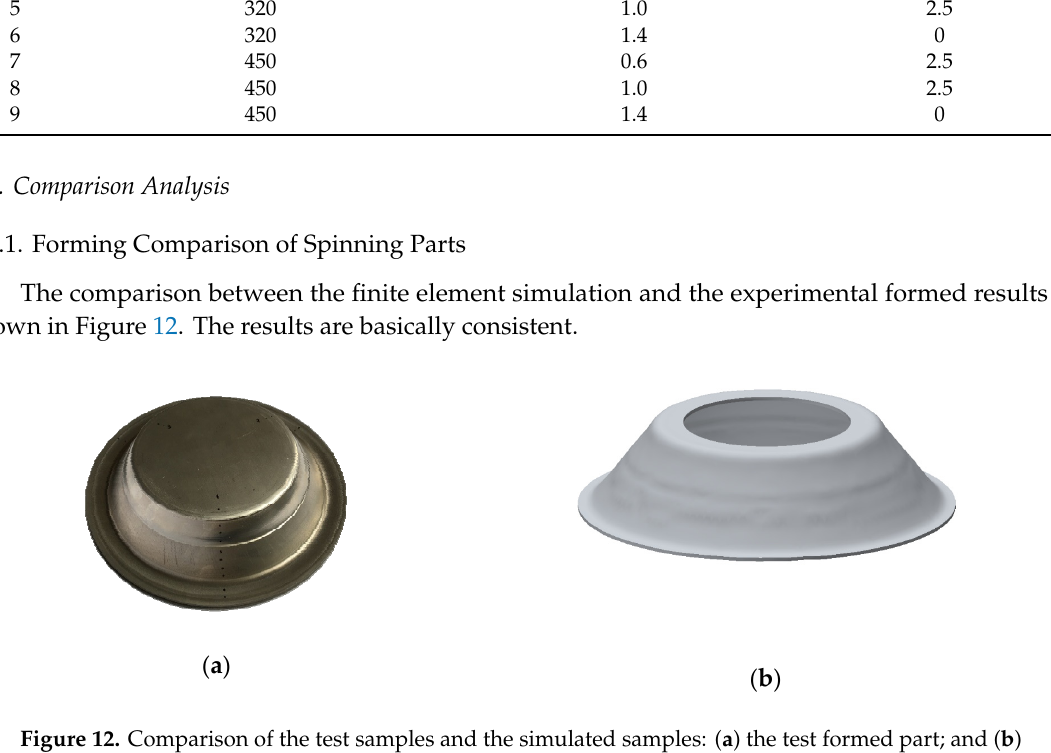
Figure 12. Comparison of the test samples and the simulated samples: ( a ) the test formed part; and ( b ) the simulation formed part.